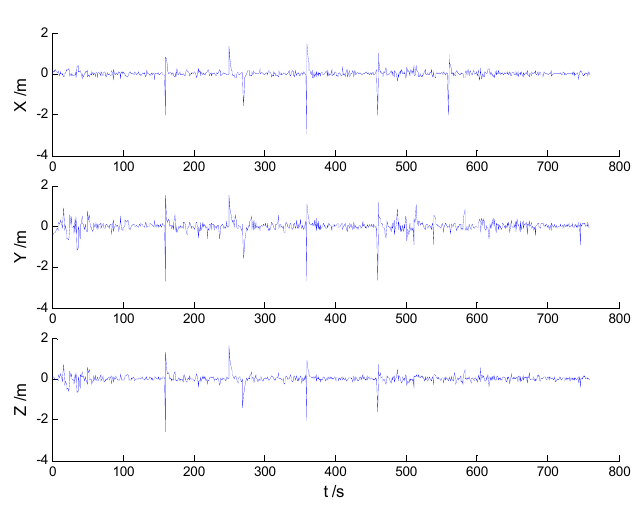
Figure 12. Position errors of the HF algorithm.